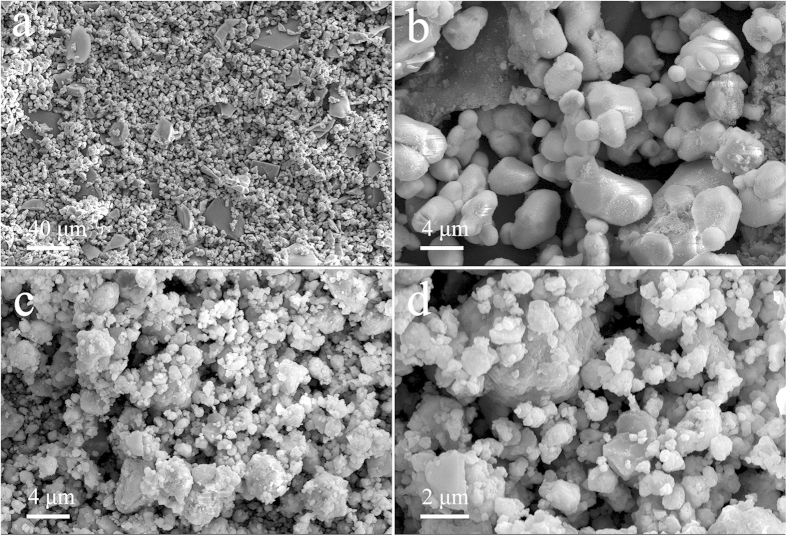
SEM images of inactivated and activated (600 rpm, 60 min) waste phosphors:(a) inactivated, ×300; (b) inactivated, ×3,000; (c) activated, ×3,000; (d) activated, ×7,000.